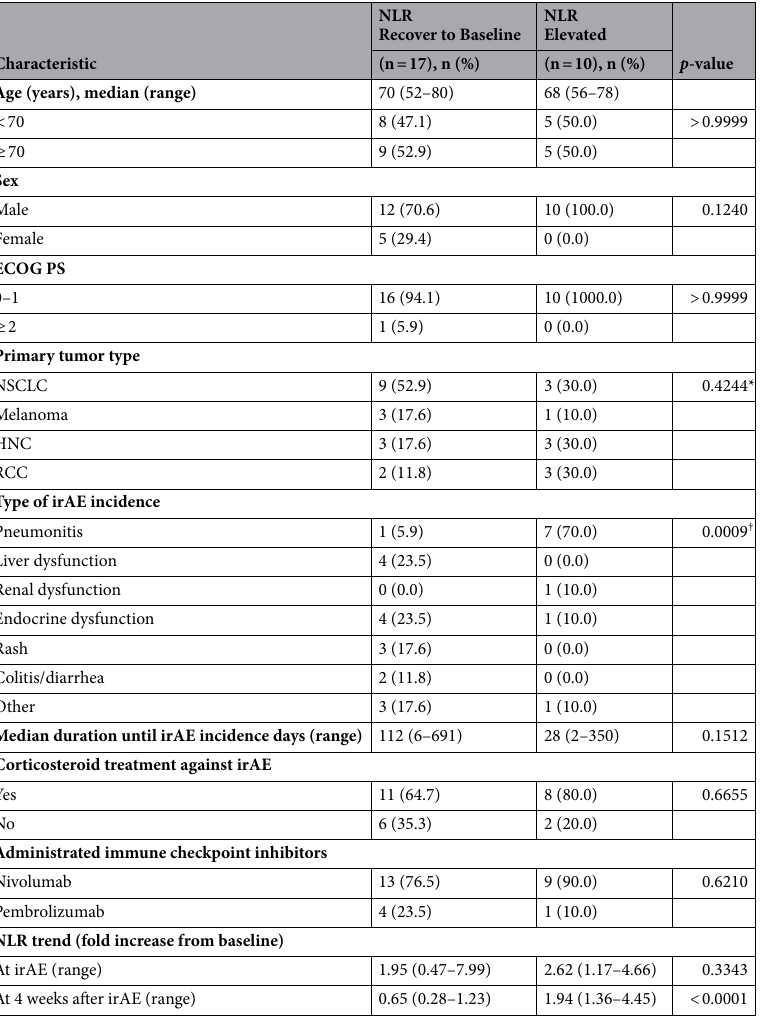
Table 3. Comparison of clinical variables in patients dichotomized via NLR trend after severe irAEs. ECOG PS Eastern Cooperative Oncology Group Performance Status, irAE immune-related adverse events,